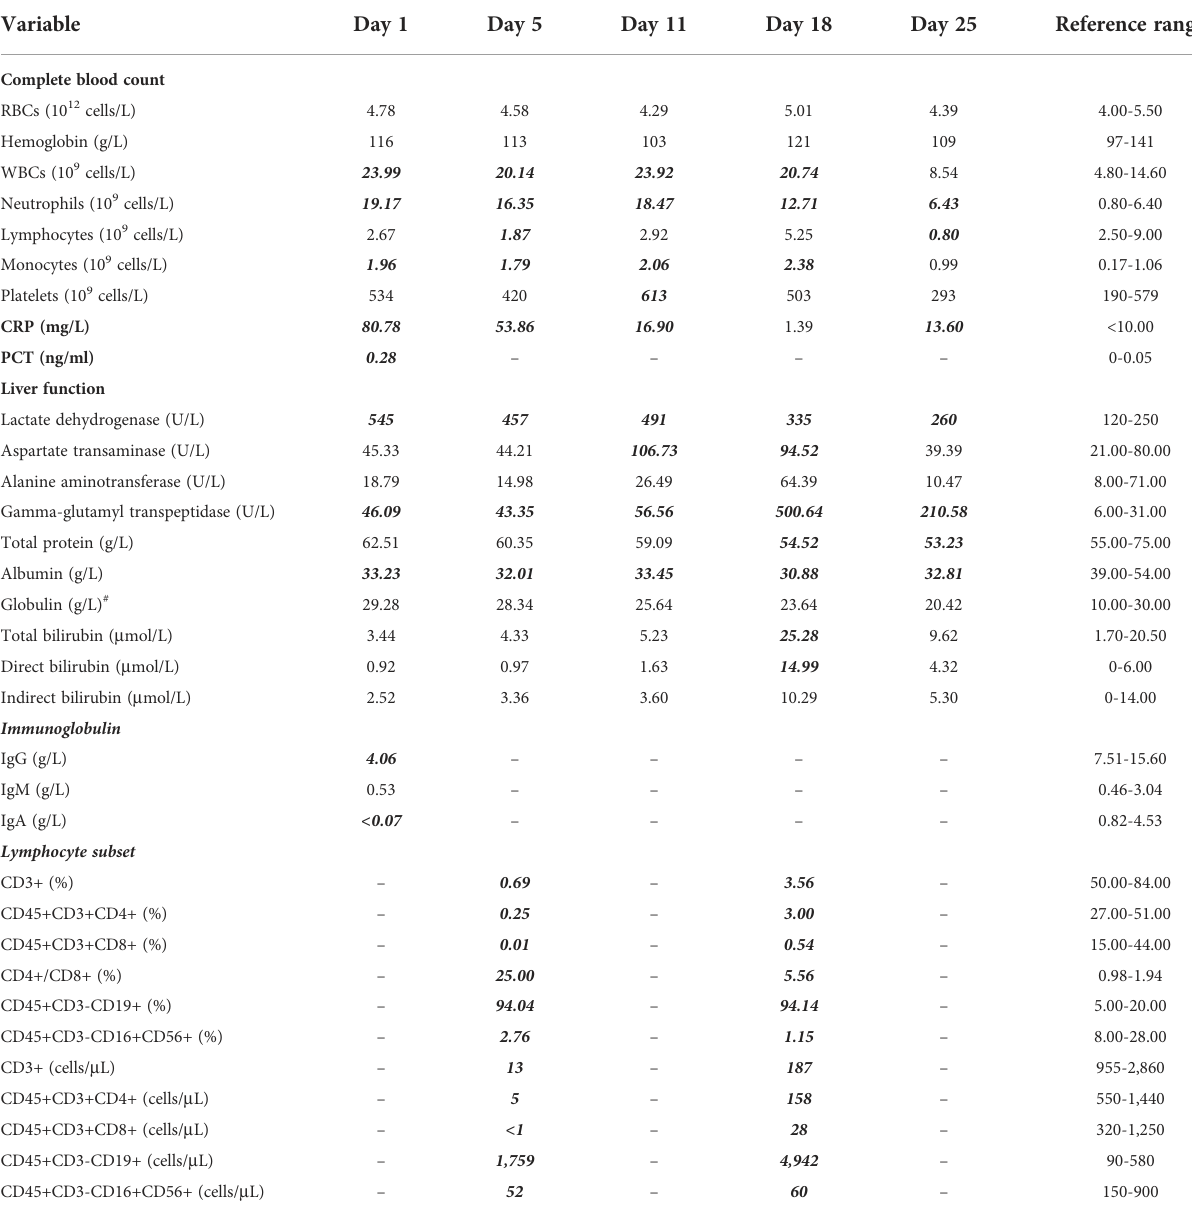
TABLE 1 Patient laboratory pro fi les after admission.